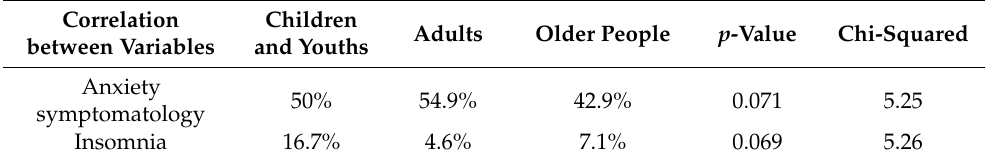
Table 3. Cross-tabulation of variables with age